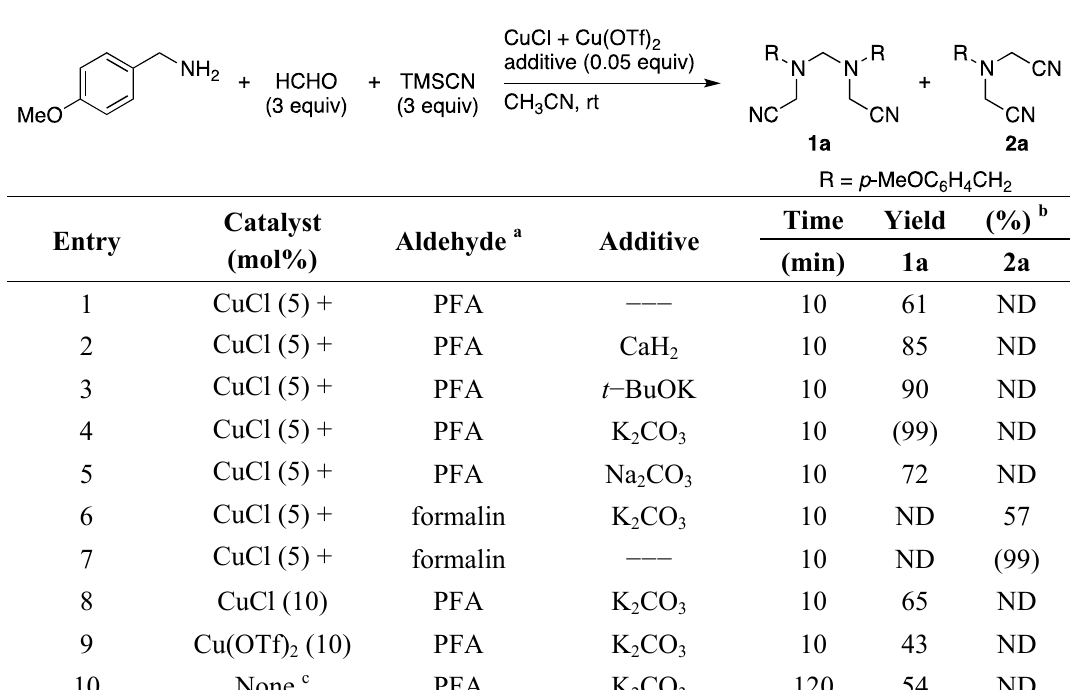
Table 1. Examination of reaction conditions.